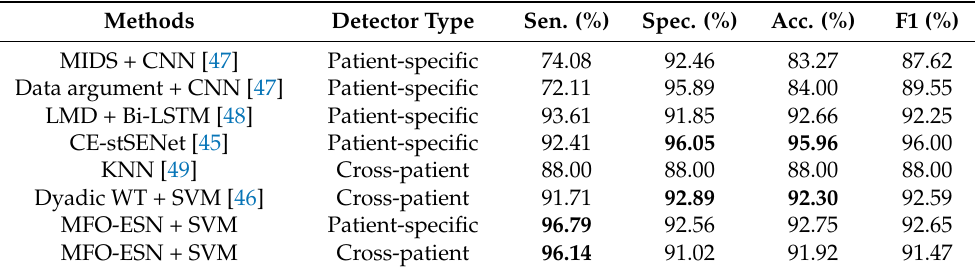
Table 5. Comparisons of results between MFO-ESN + SVM and other